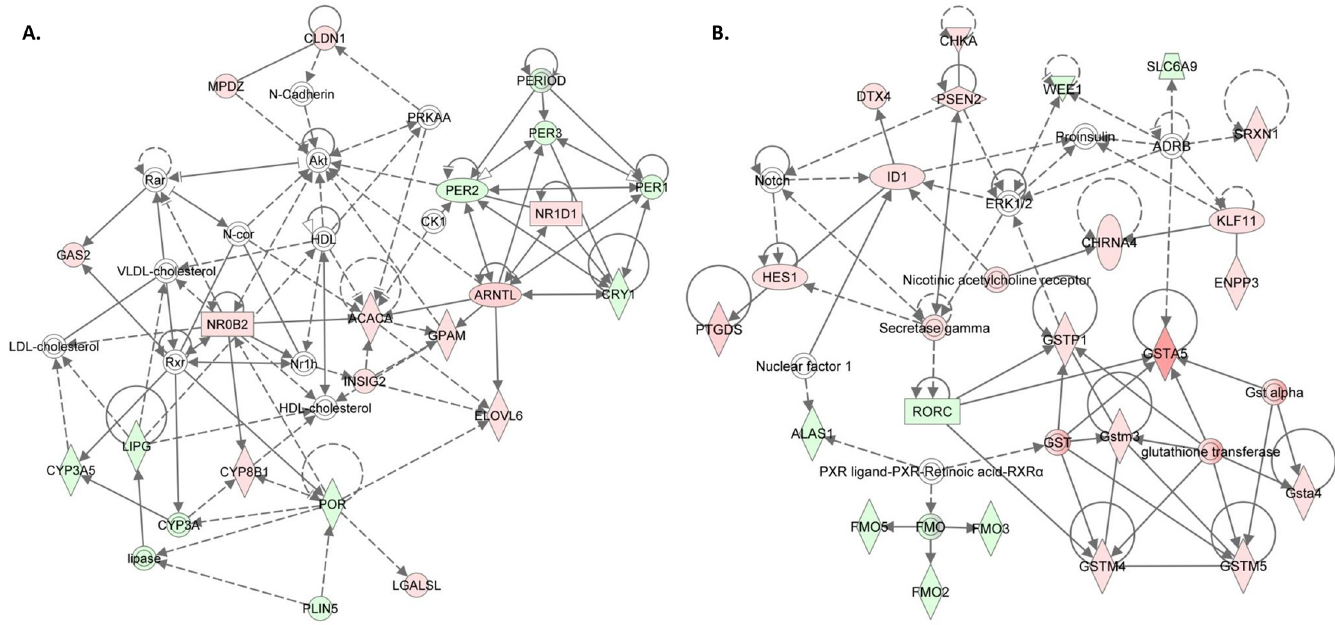
Fig 4. Top networks of differentially expressed genes between CTRL and SUPP offspring unique to females. A) . Network associated with ‘ Lipid Metabolism ’ , ‘ Behavior ’ and ‘ Nervous System Development and Function ’ . Score = 36. B) . Network associated with ‘ Glutathione Depletion in Liver ’ , ‘ Drug Metabolism ’ and ‘ Protein Synthesis ’ . Score = 44. Red = up-regulated in SUPP, Green = down-regulated in SUPP. Unshaded genes are present in the biological network but were not significantly altered in our dataset. The network score is a negative log p value of the Fisher exact test, which is testing whether these genes are grouped by